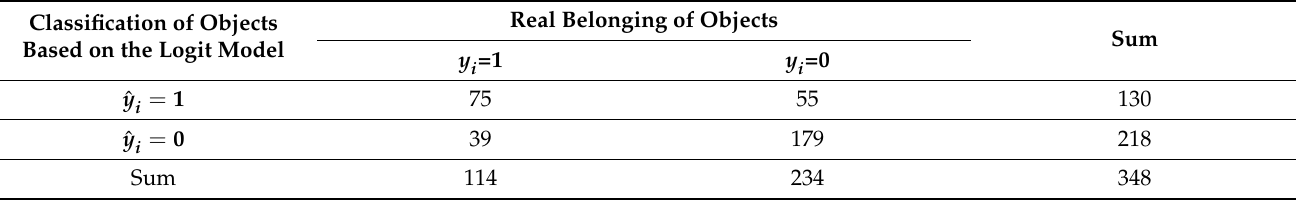
Table 4. Matrix of case